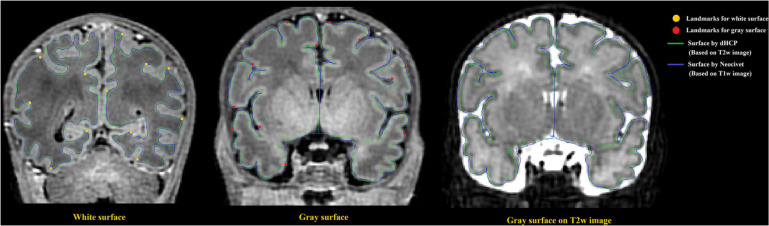
Examples of surface validation points (landmarks) placed on the WM/GM boundary and the GM/CSF boundary of a randomly selected T1 weighted image from the dHCP dataset. Left: Surface validation points from the WM surface are shown along with the dHCP and our WM surface reconstruction solutions; Middle: Validation points from the pial surface are shown along with the dHCP and our pial surface reconstruction solutions. Right: Pial surface were mapped to same MRI slice from the dHCP dataset as shown in middle panel but with T2 modality. Note that the dHCP surfaces are extracted on T2 weighted images that may estimate CSF partial volume and pial surface differently. The dHCP surfaces are indeed observed to fit better the pial boundaries found on T2 weighted images than those on T1 weighted.